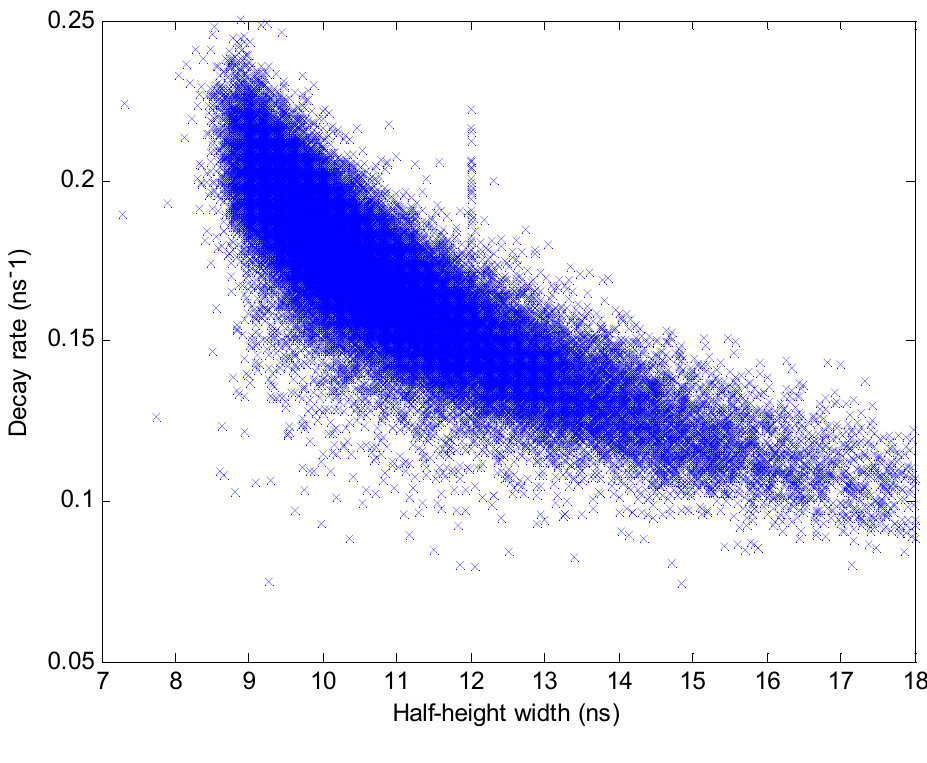
Figure 9. Scatter plot of half-height width vs . decay rate for curve fits on deconvolved waveform